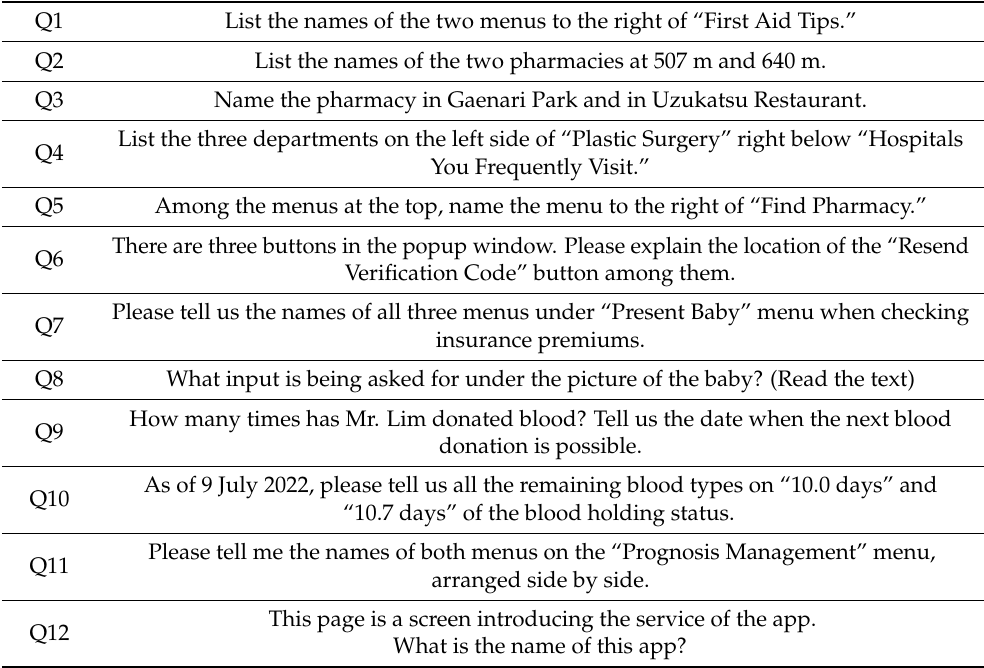
Table 3. Questions in the VCDA test